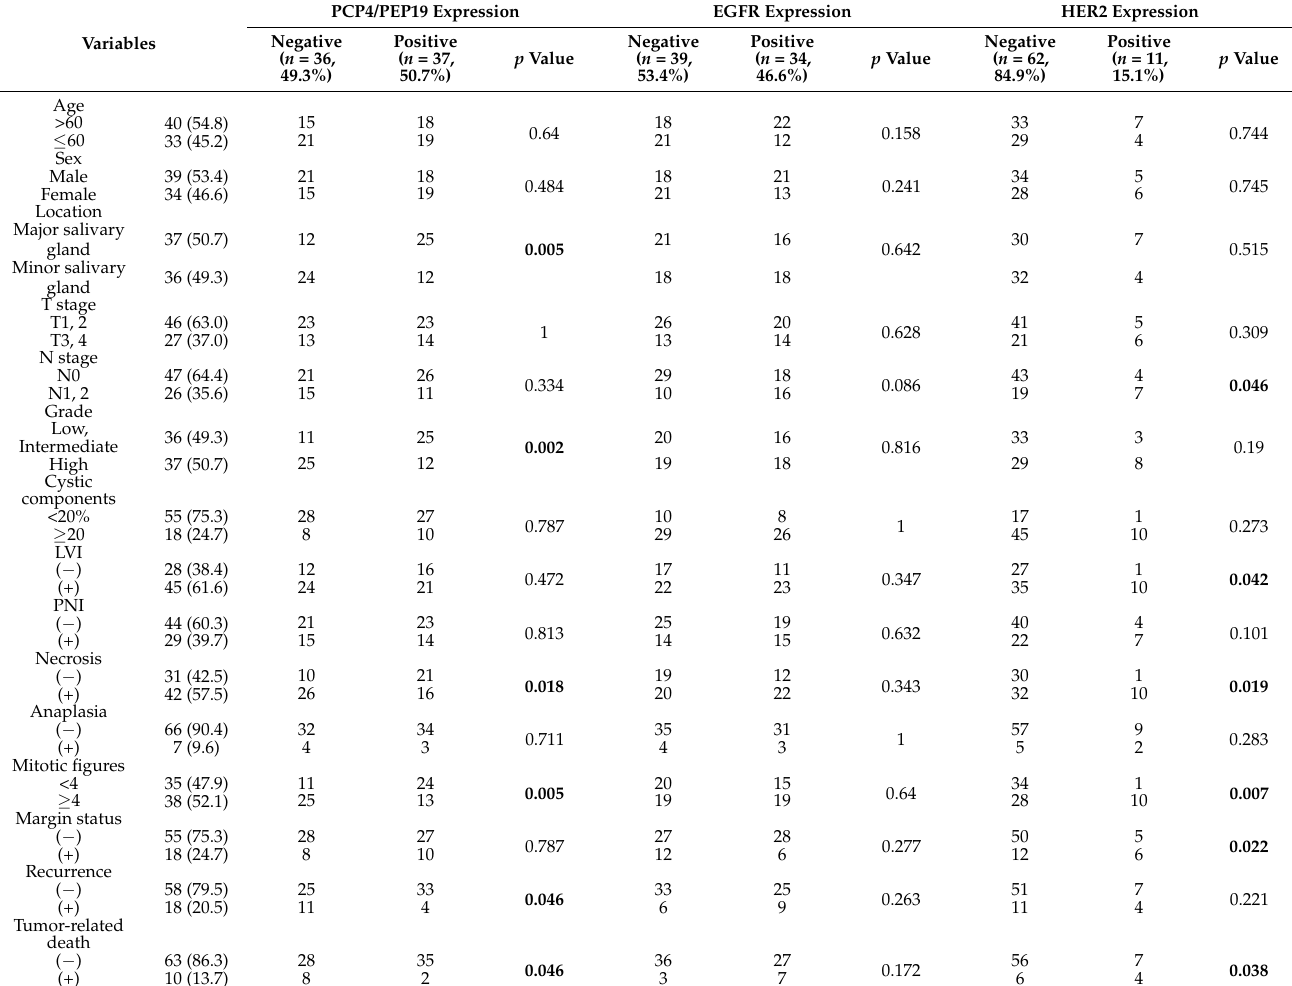
Table 2. The relationship between PCP4/PEP19 expression and EGFR/HER2